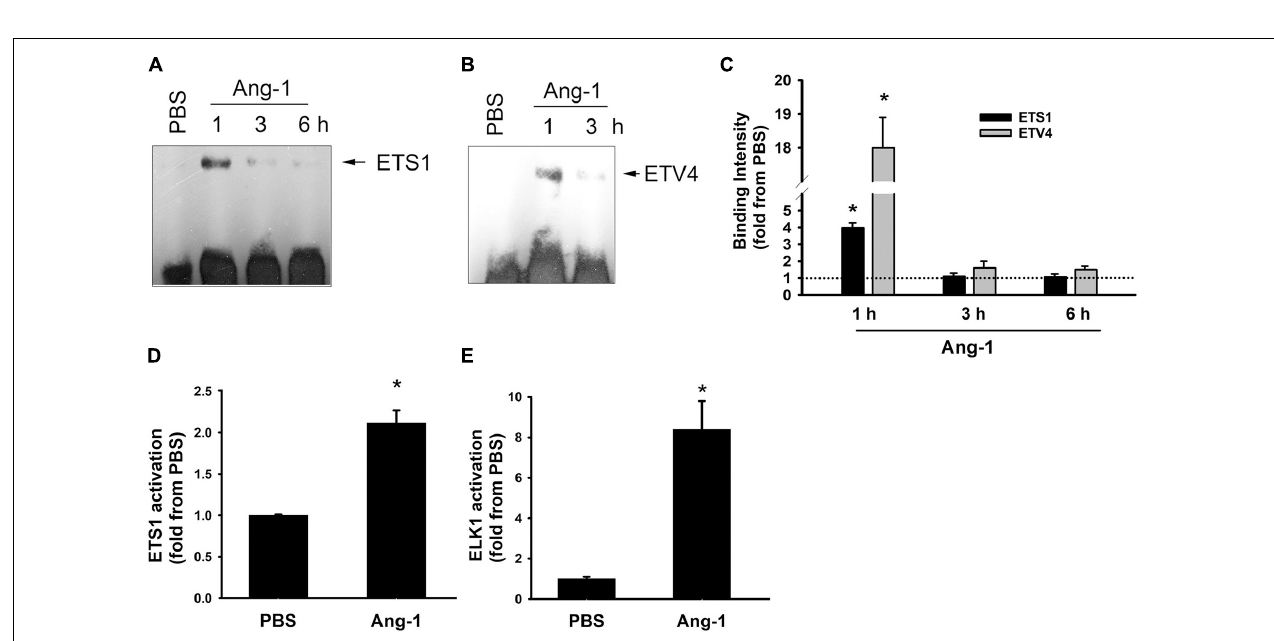
FIGURE 3 | Ang-1 activates ETS1, ELK1, and ETV4 TFs. (A–C) Representative examples of electrophoretic mobility shift assays and mean values of probe binding intensity (expressed as fold from PBS) of ETS1 and ETV4 in response to PBS or Ang-1 exposure. N = 3. (D,E) Luciferase reporter activities of ETS1 and ELK1 in HUVECs exposed to PBS or Ang-1 for 4 h. Values are means ± SEM, expressed as fold from PBS. * P < 0.05, compared to PBS. N = 6 per condition.